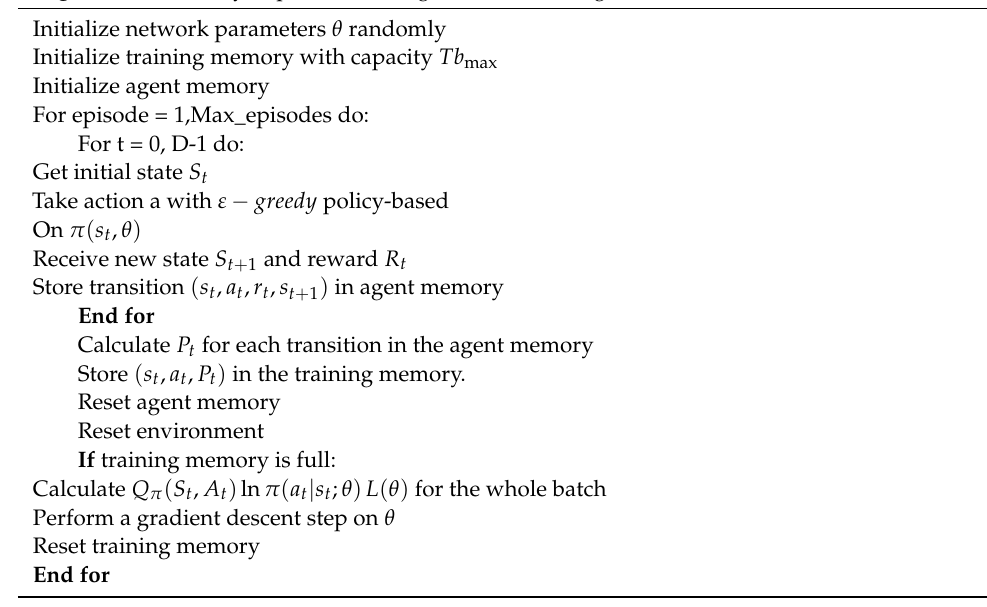
Algorithm 1: Priority Experience Storage Actor-Critic Algorithm